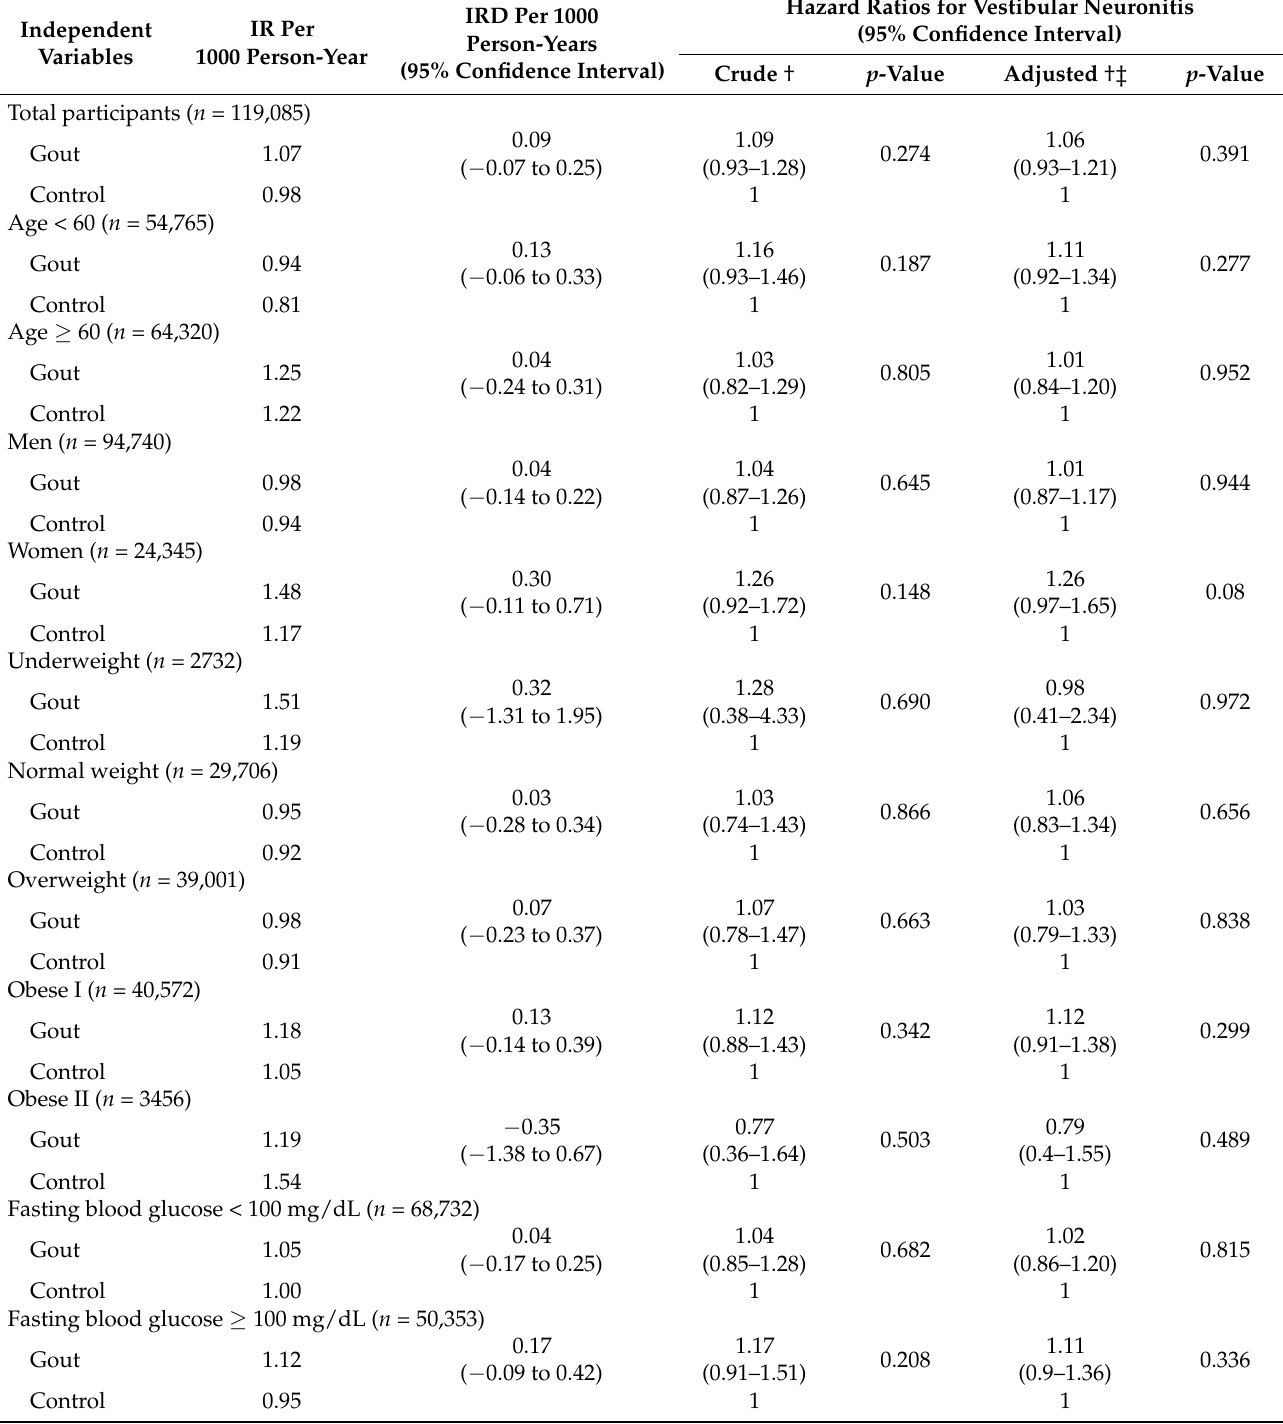
Table 4. Crude and adjusted hazard ratios of Gout for Vestibular neuronitis with subgroups according to age and sex with subgroups according to age, sex, obesity, and fasting blood